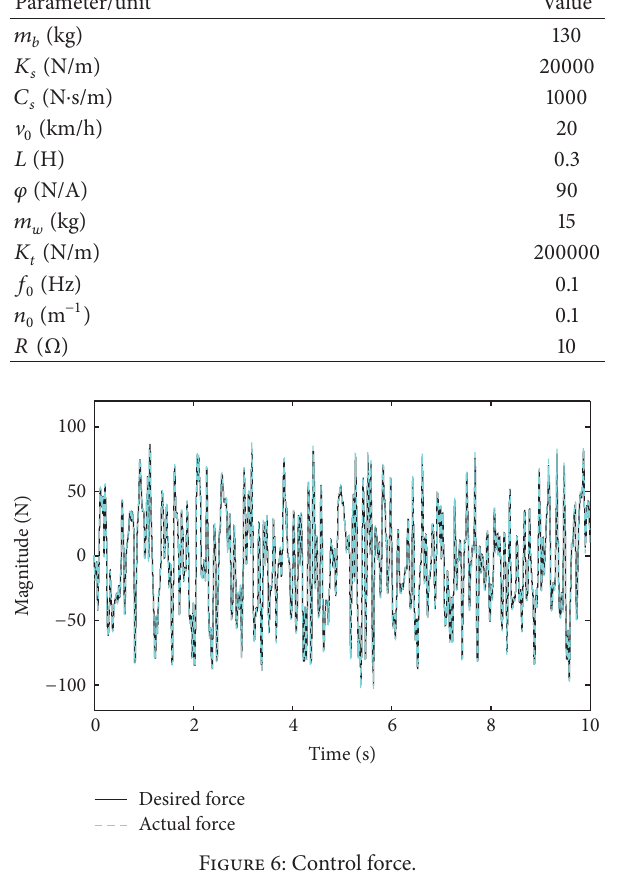
Figure 6: Control force.